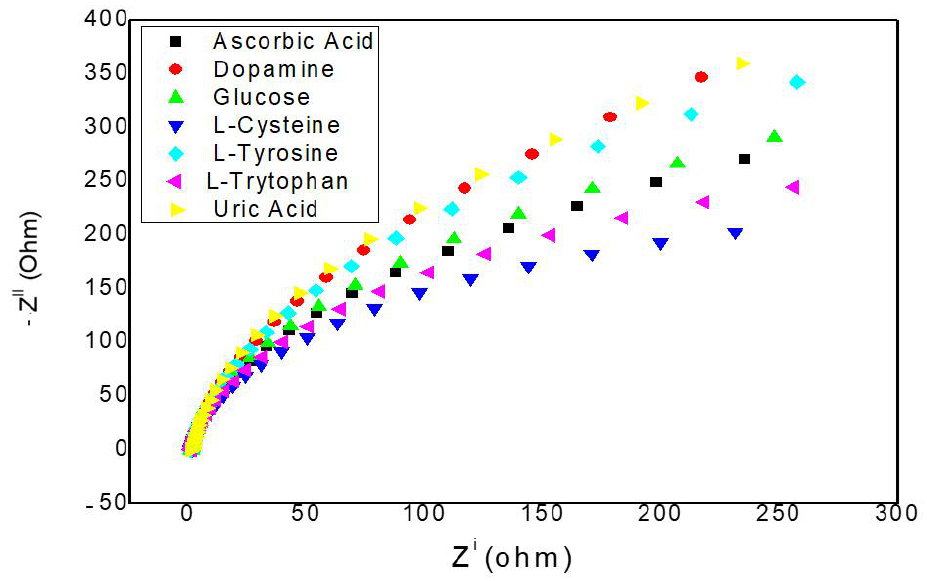
Figure 10. EIS results for interfering species of 0.1 mM uric acid, 0.1 mM ascorbic acid, 0.1 mM L-tyrptophane, 0.1 mM L- tyrosine, 0.1 mM L-C, 0.1 mM dopamine at −0.2 V on Mo/CNT/GCE at the frequency range (0.02–100,000 Hz), signal amplitude (10 mV).